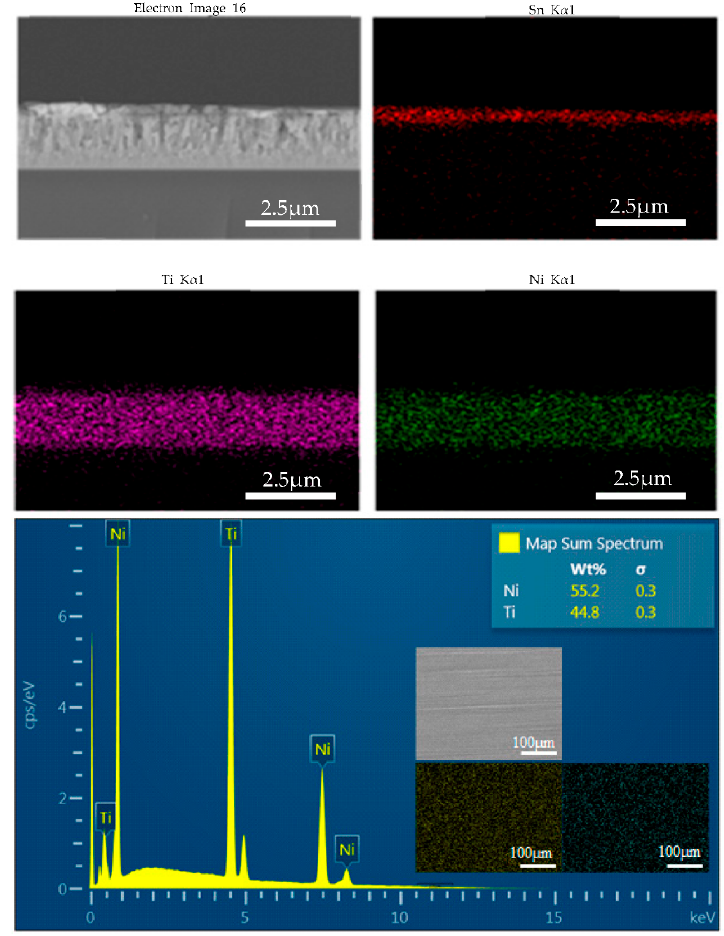
Figure 3. Energy-dispersive X-ray spectrum and mapping image of the TiNi thin film.